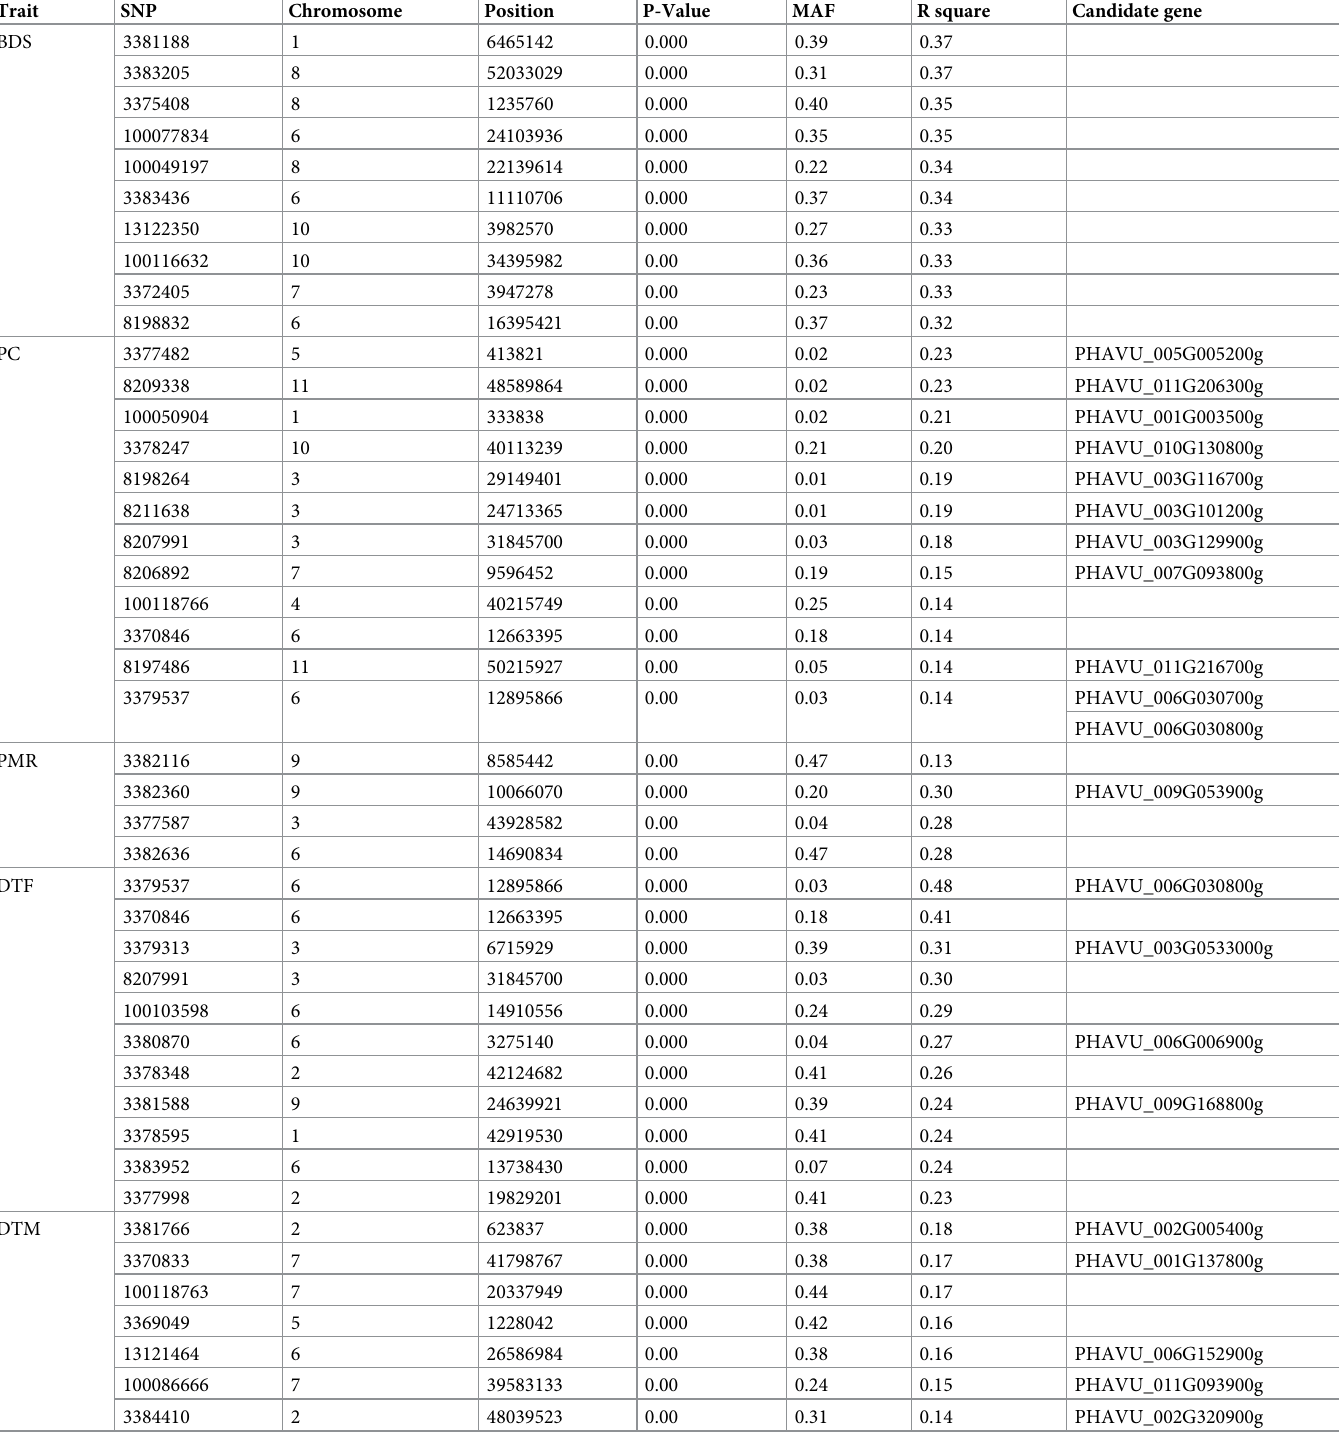
Table 4. Significant markers for bean fly resistance and agronmic traits and putative genes identified in 93 common bean genotypes assessed in two locations (Chit- edze and Mbawa research stations) and two years (2018 and 2019) in Malawi.